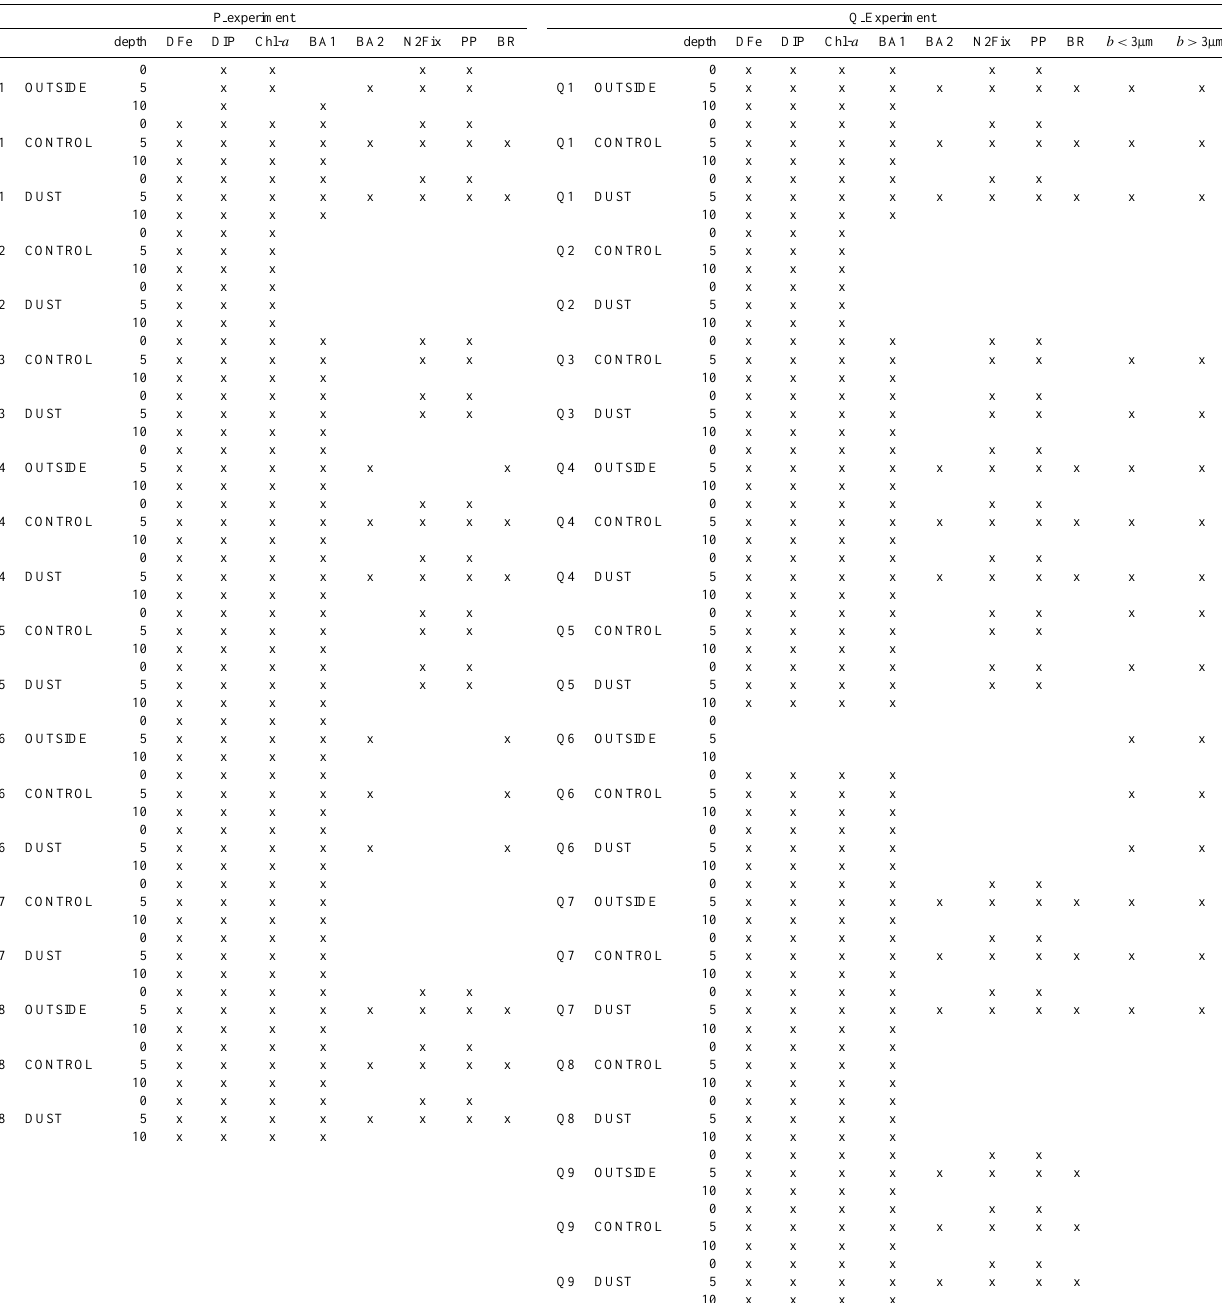
Table 3. Sampling planning. The corresponding sampling time/day are reported in Table S1 (supp.